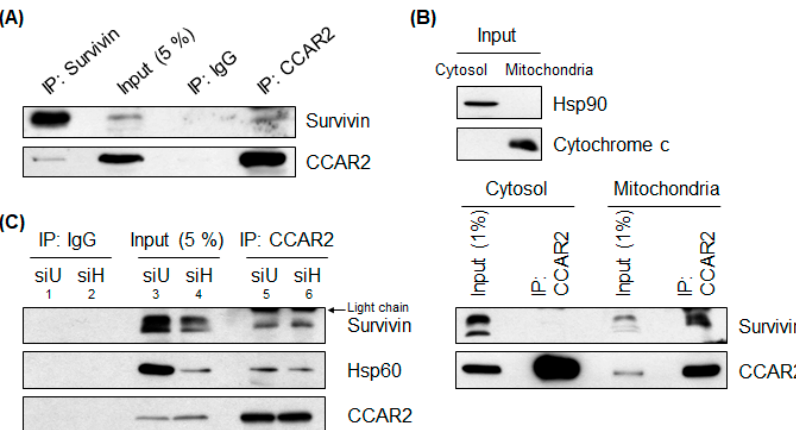
Figure 1. CCAR2 binds Hsp60 and survivin. Interaction between CCAR2 and survivin was examined in SH-SY5Y or HEK293 cells by co-immunoprecipitation with either an anti-CCAR2 or an anti-survivin antibody, followed by western blotting. ( A ) Interaction between CCAR2 and survivin in whole cell lysates from SH-SY5Y cells was examined. ( B ) Interaction between CCAR2, survivin, and Hsp60 in cytosolic and mitochondrial fractions isolated from HEK293 cells was examined. ( C ) SH-SY5Y cells were depleted of Hsp60 and the interaction between CCAR2 and survivin was examined. siU, universal siRNA; siH, Hsp60 siRNA.